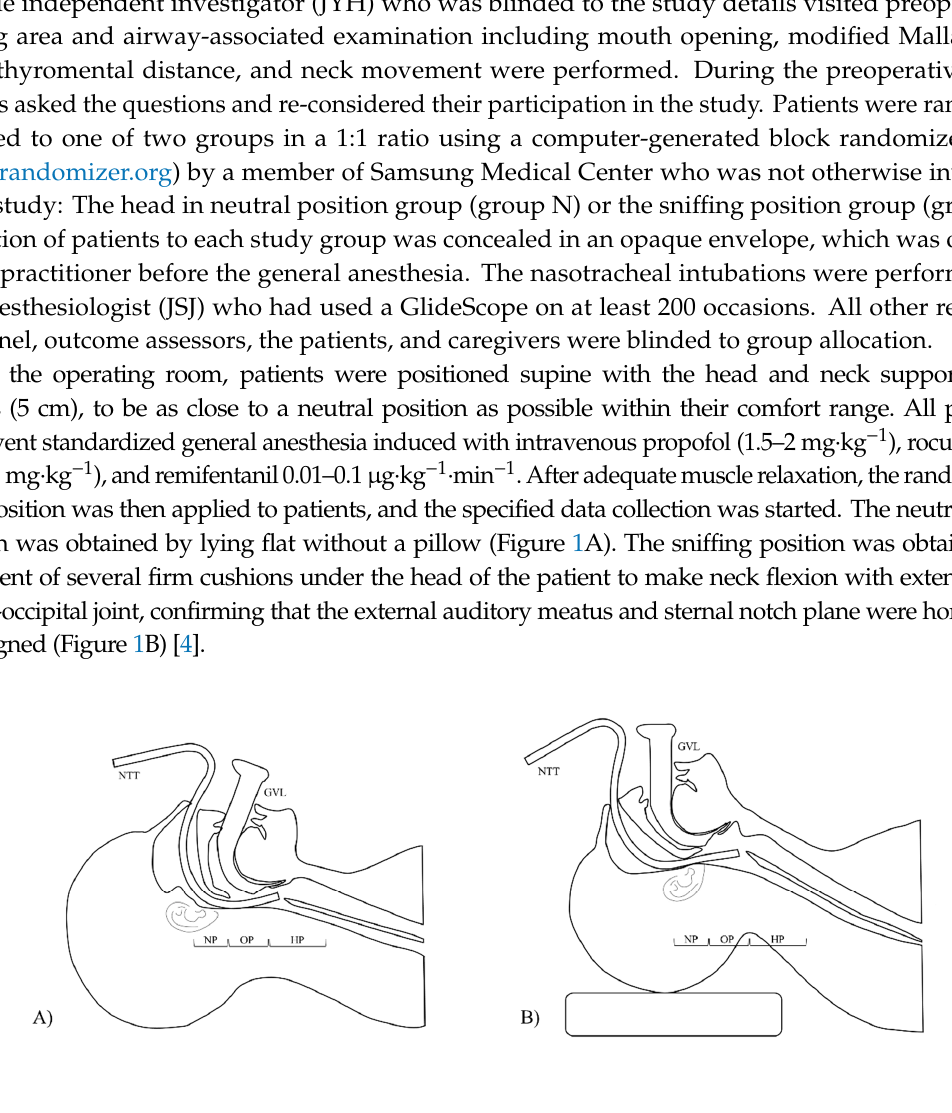
Figure 1. Head positions for intubation. ( A ) Neutral position and ( B ) sniffing position. GVL, GlideScope videolaryngoscope; HP, hypopharynx; NP, nasopharynx; NTT, nasotracheal tube; OP, oropharynx.